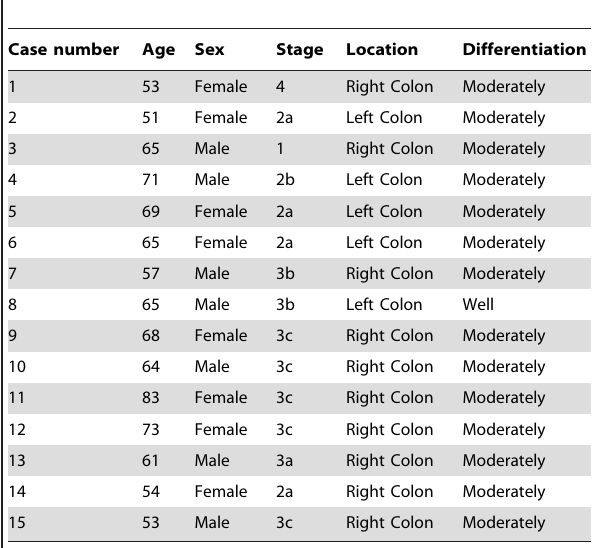
Table 2. Number and frequency of aberrations per